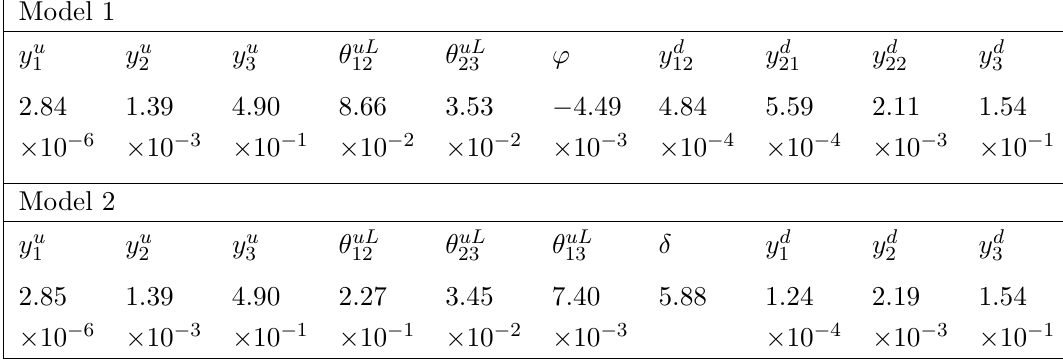
Table 4 . The flavor input parameters for the best-fit point of models 1 and 2. The GUT phases φ 1 and φ 2 have no influence on the predictions.